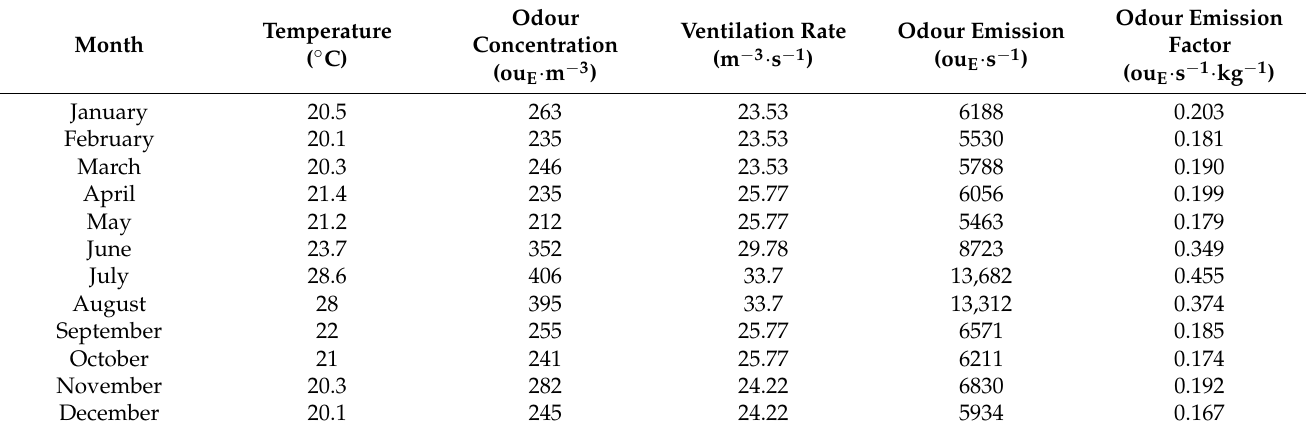
Table 2. Mean odour concentration and odour emission factor for breeding hens for eggs.